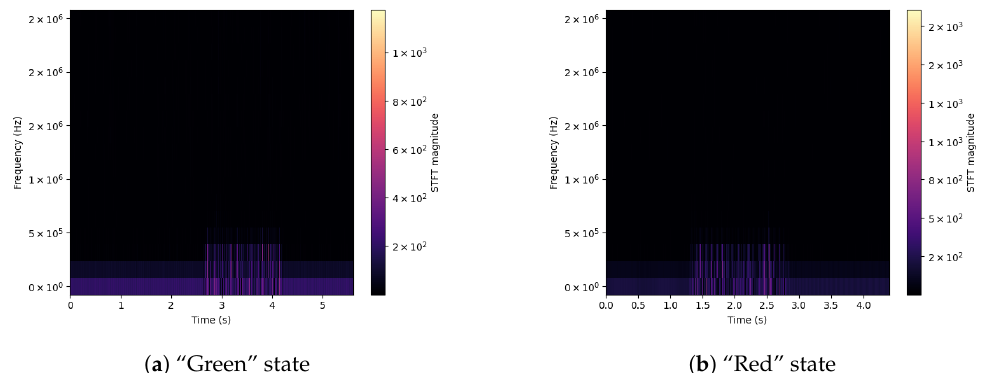
Figure 3. Signal spectrograms of Acoustic Emission for Green/Red states.